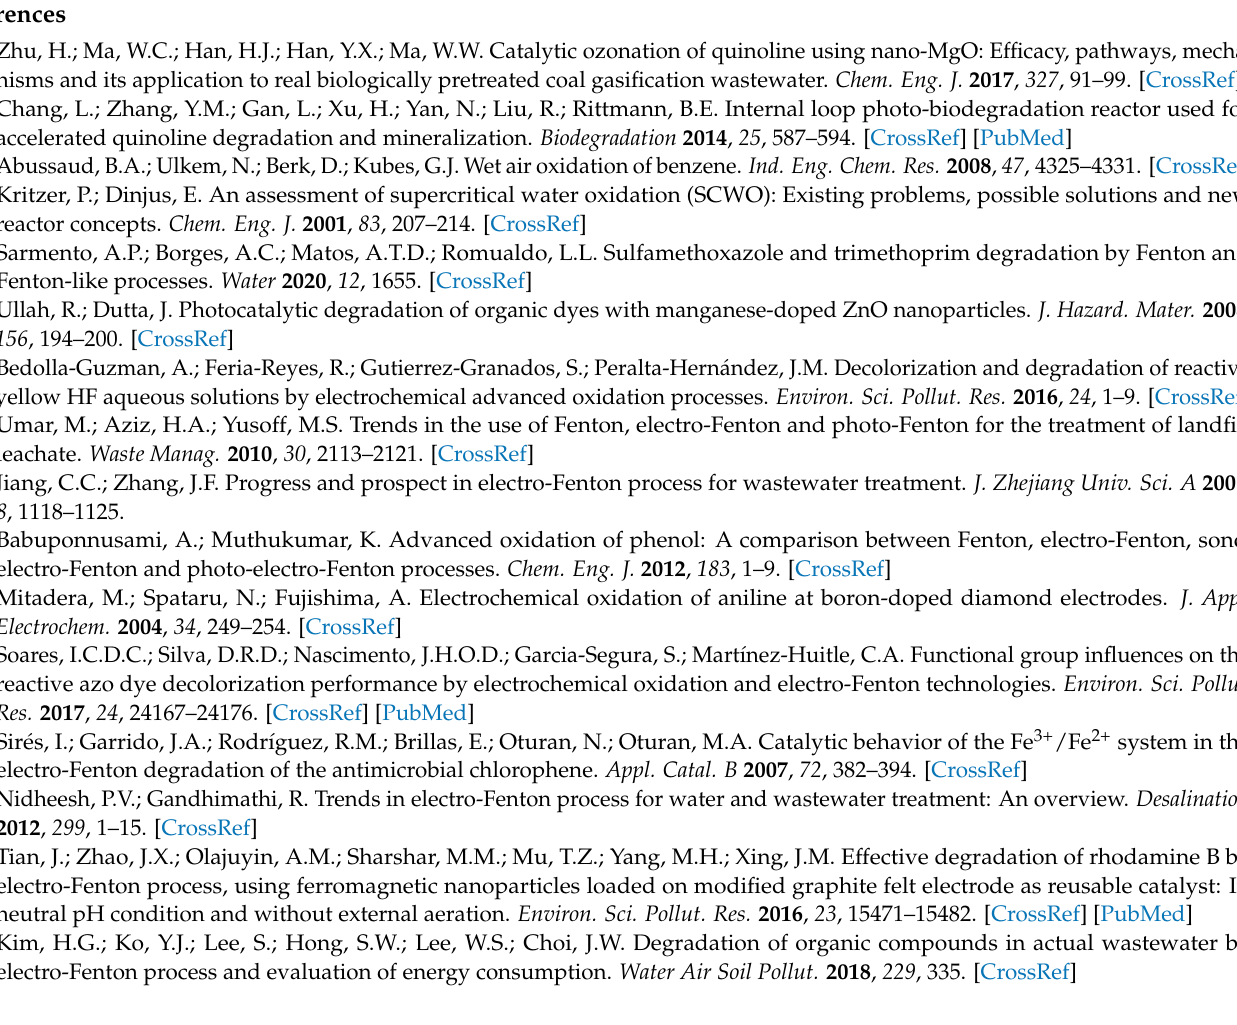
Table S3. The main intermediates during quinoline degradation identified by GC–MS; Tables S4–S12. Results of computational analysis for the intermediates; Table S13. The results of mass balance and cost calculation in the E-Fenton process under the optimal process